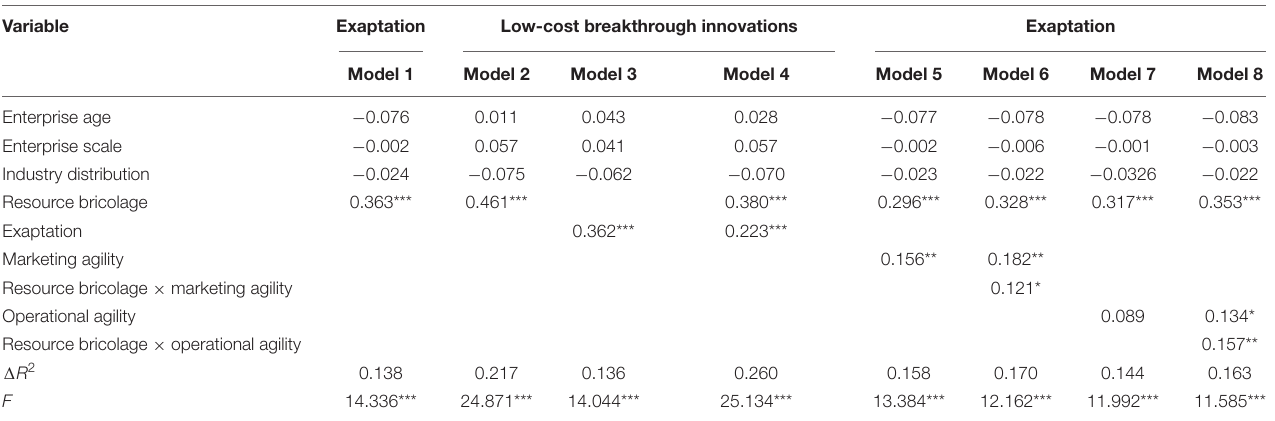
TABLE 3 | Regression analysis